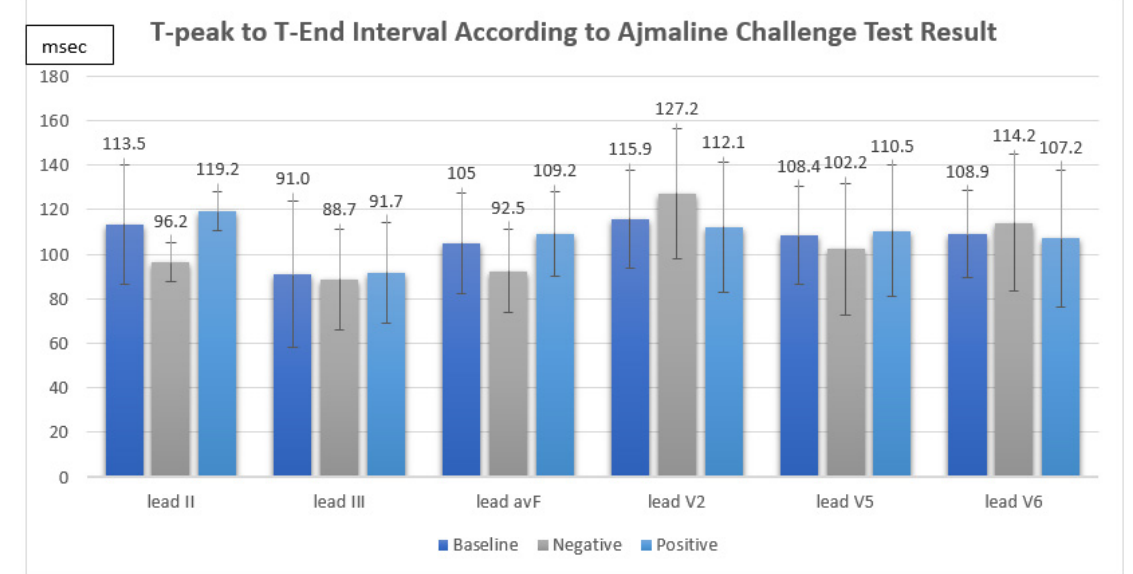
Figure 1. T-peak to T-end interval according to ajmaline challenge test result. 3.3. Electrocardiographic Parameters at Baseline and End of the Test After the ajmaline challenge test, the corrected QT interval and S-wave duration (lead II, V5) were significantly increased (QTc: Baseline 415.7 ± 29.6 ms vs. End of test 465.9 ± 34.3 ms, Mean difference 52.5 ± 38.2 ms, p < 0.001, S: II Baseline 41.2 ± 14.2 ms vs. End of